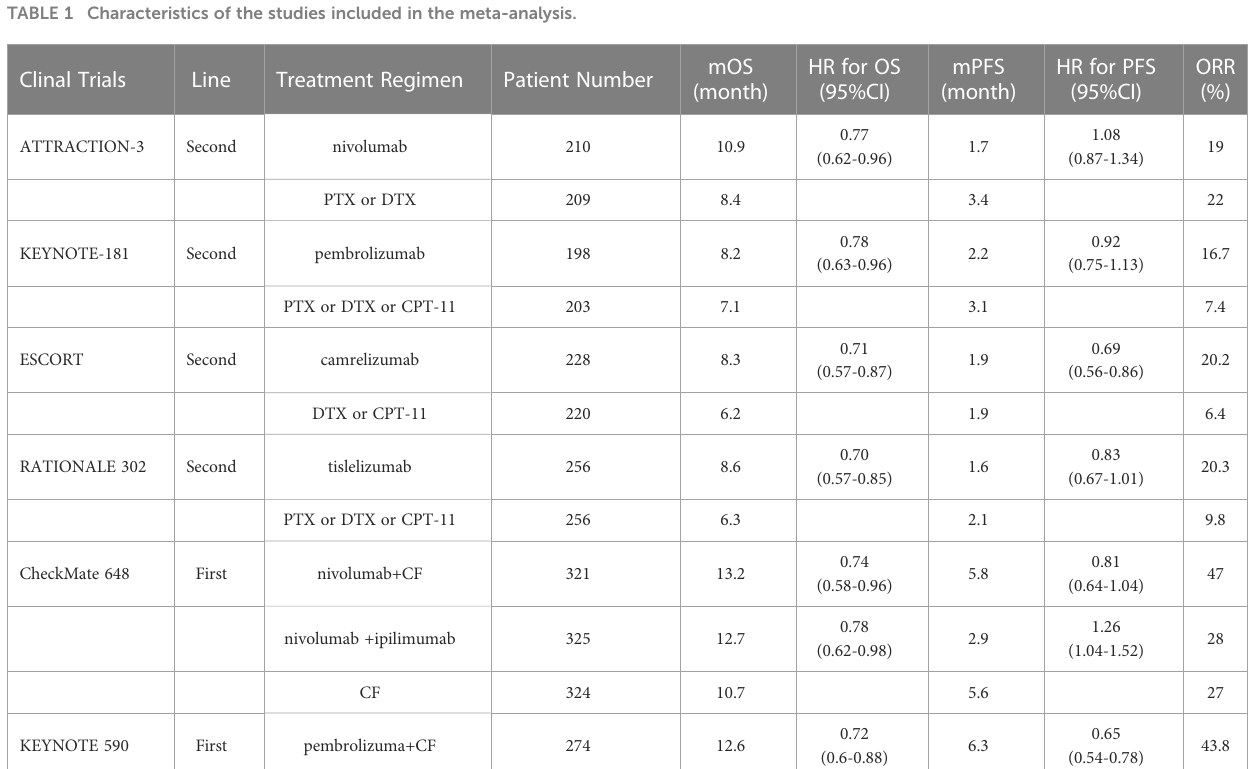
TABLE 1 Characteristics of the studies included in the meta-analysis.